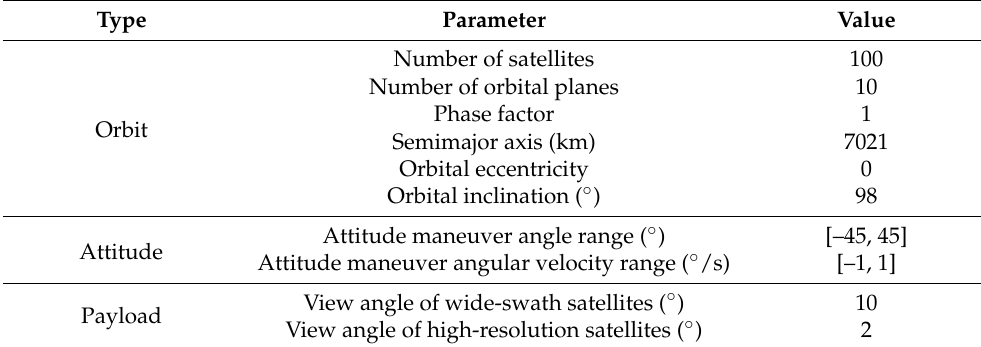
Table 6. Parameters of the satellite constellation.